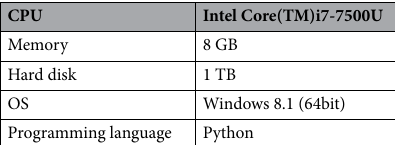
Table 1. Software and hardware environment.